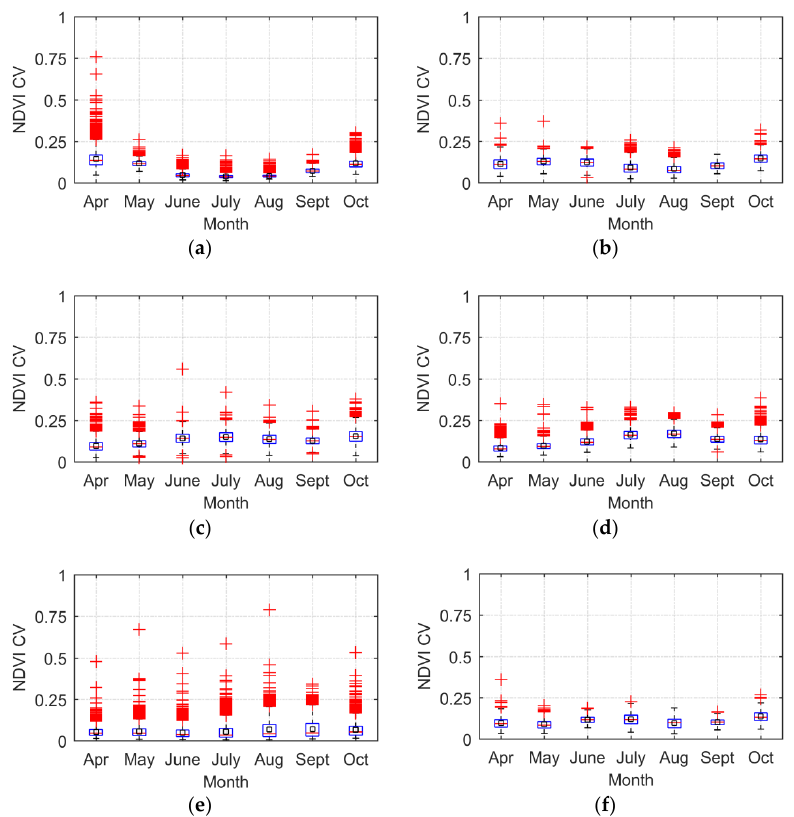
Figure 4. Mean CV of the monthly NDVI during the growing season for the ( a ) forest, ( b ) meadow, ( c ) typical steppe, ( d ) desert steppe, ( e ) desert, and ( f ) crop biomes in Inner Mongolia from 1982 to 2015. The bottom and top edges of each blue box represent the 25th and 75th percentiles, respectively. The horizontal red line in each blue box indicates the median values. The open black square in each blue box means mean values. The black whiskers extend to the 1.5 times the interquartile range. Red crosses represent